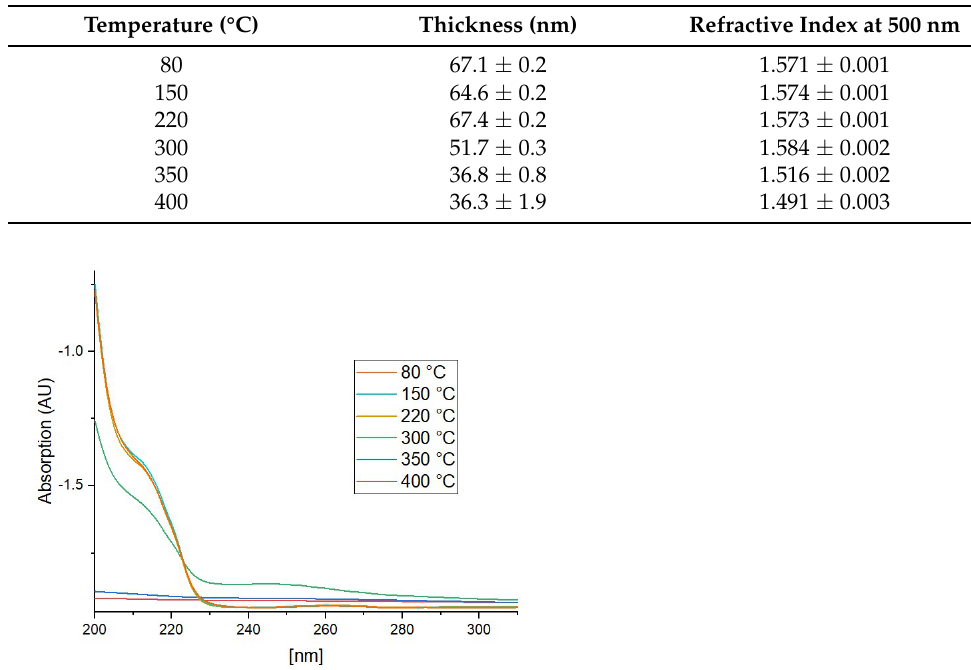
Table 1. Thickness and refractive index evolution of PSAN thin film with wt = 0.5% annealed at different temperatures.